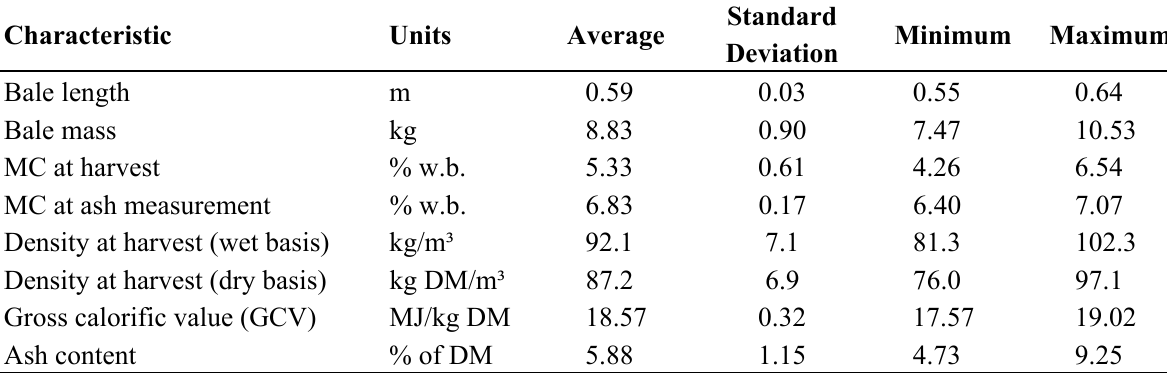
Table 1. Characteristics of corn stover bales at harvest, and at ash and GCV measurement.